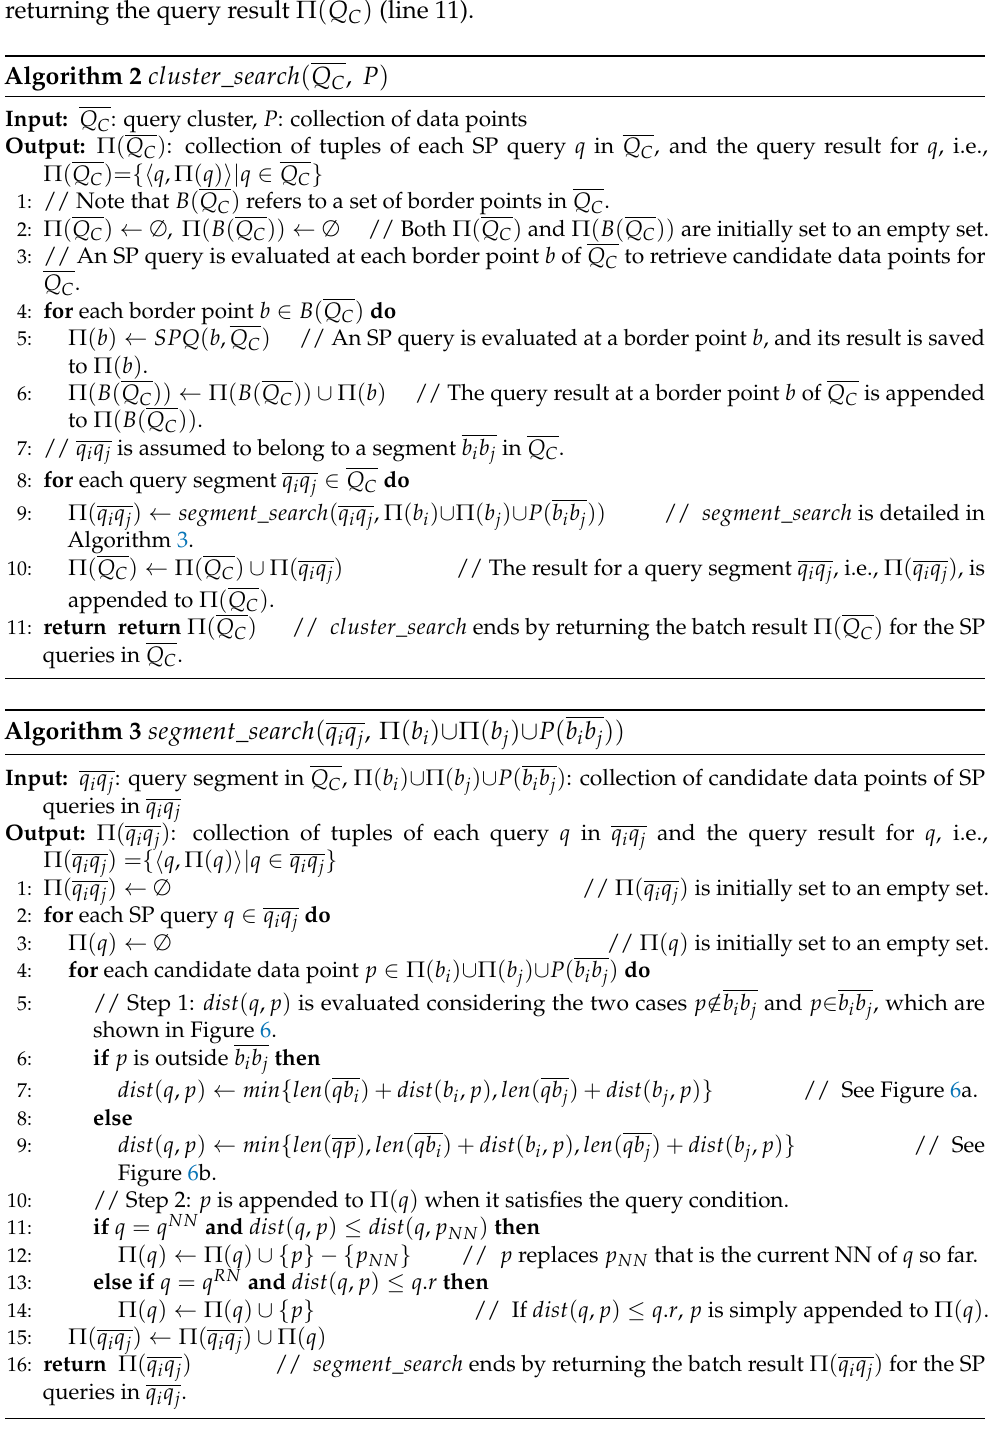
Algorithm 3 describes the segment search algorithm employed to answer the